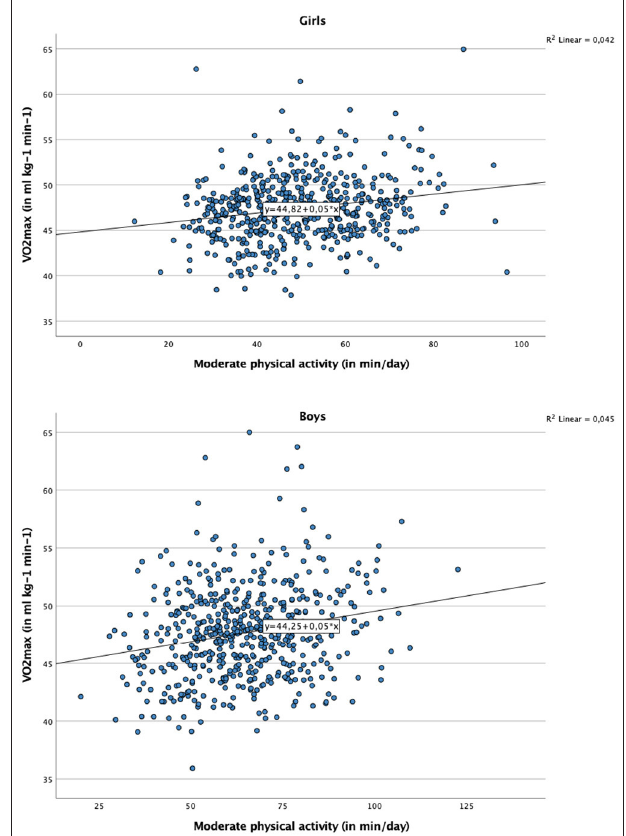
FIGURE 3 | Scatter plot with regression line representing the association between moderate physical activity and cardiorespiratory fitness, for girls and boys from South